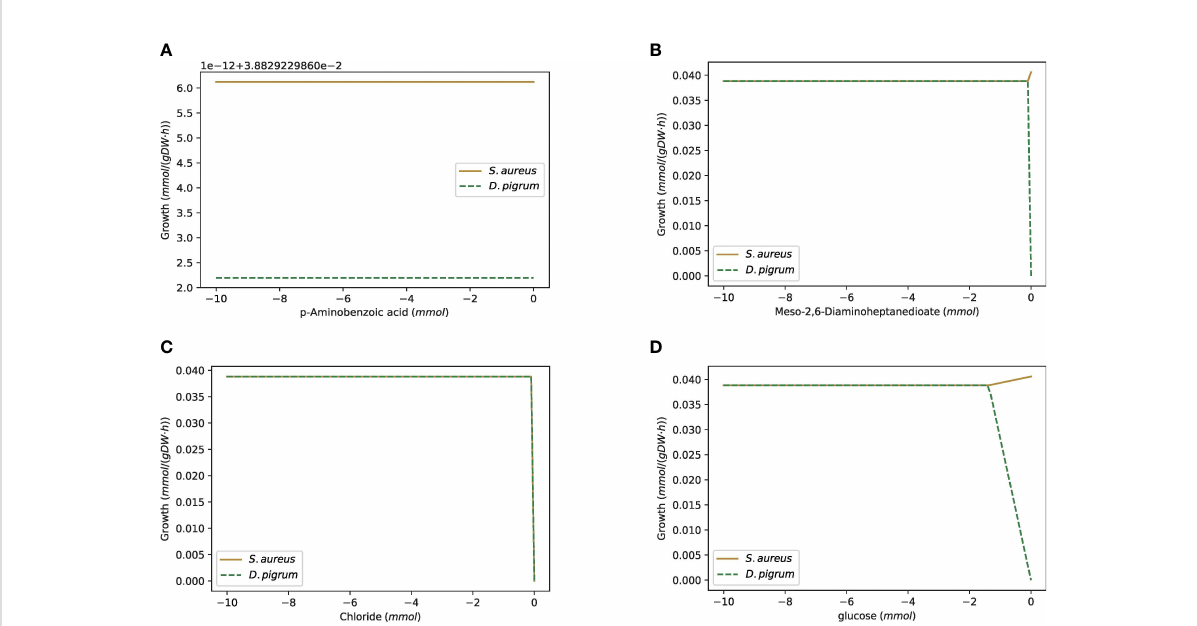
FIGURE 9 The robustness analysis of the COOPM community of D. pigrum and S. aureus with respect to alterations of the fl ux levels of all essential metabolic reactions included in the community. The gold line represents the growth of S. aureus and the green one is for D. pigrum . (A) The change of 4 aminobenzoate exchange. The changes of MoO 4 – 2 (molybdate) and thiamin exchanges follow the same plot. (B) The change of the meso-2,6-diaminoheptanedioate exchange. The changes of Ca 2+ , Co 2+ , Cu 2+ , Ni 2+ , L-Proline, and L-threonine follow the same plot. (C) The change of the Cl – exchange. The changes of Fe 2+ , K + , Mg 2+ , Mn 2+ , Na + , Zn 2+ , Nicotinate, O 2 , SO 2 (cid:3) 4 (sulfate), and L-cysteine exchange follow the same plot. (D) The change of the D-glucose exchange.